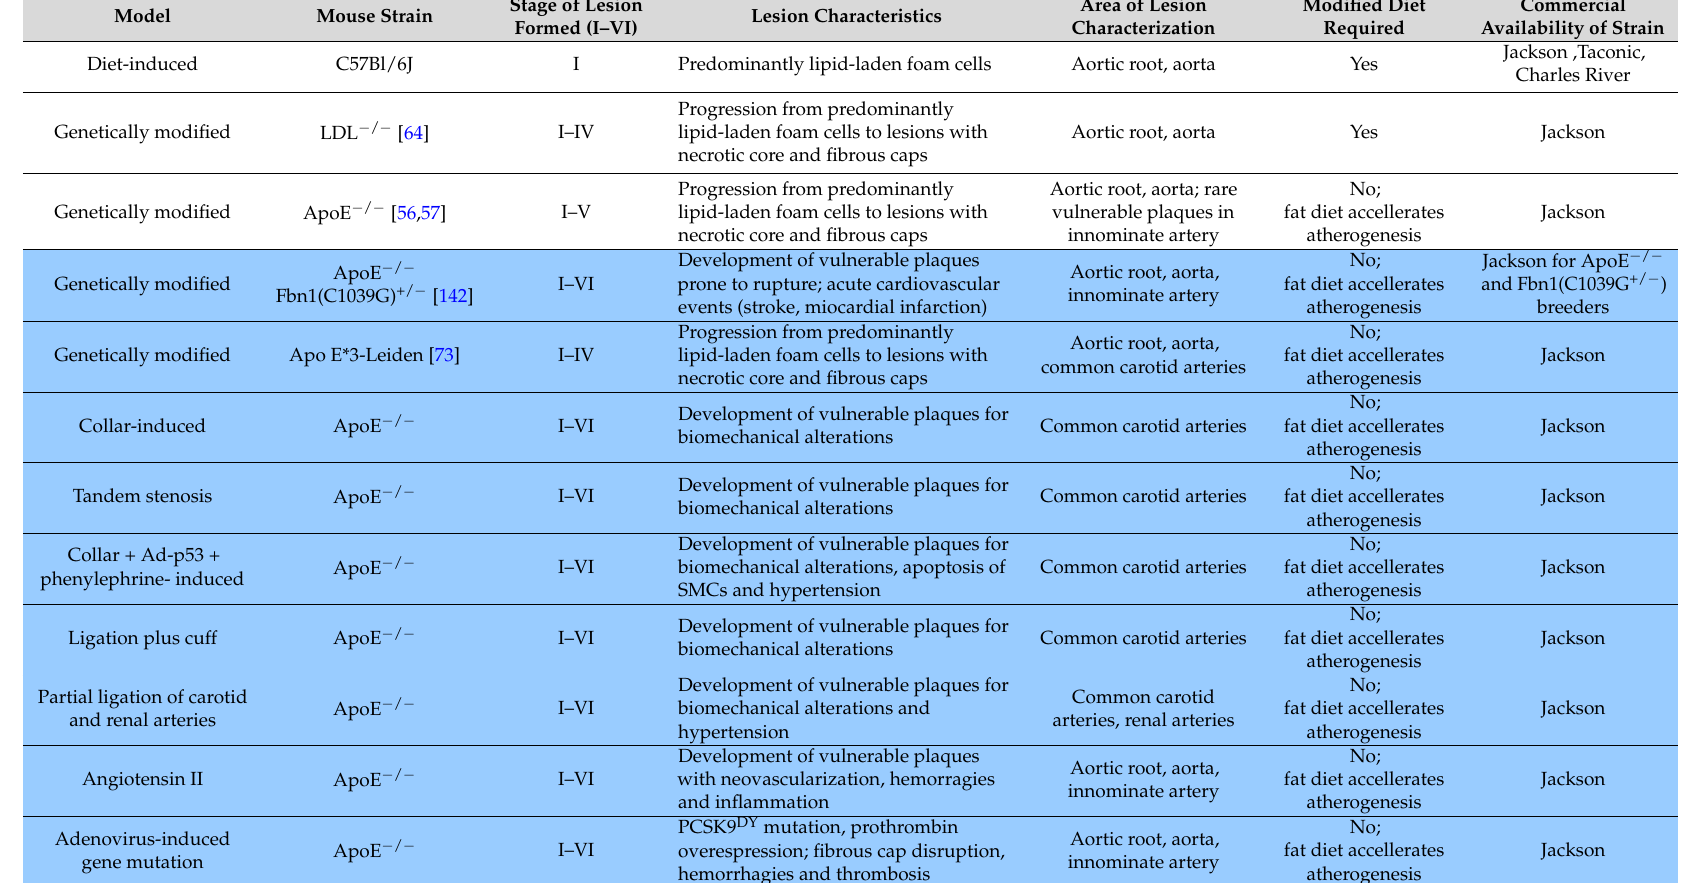
Table 1. Summary of major mouse models of atherosclerosis with features of vulnerability (highlighted in